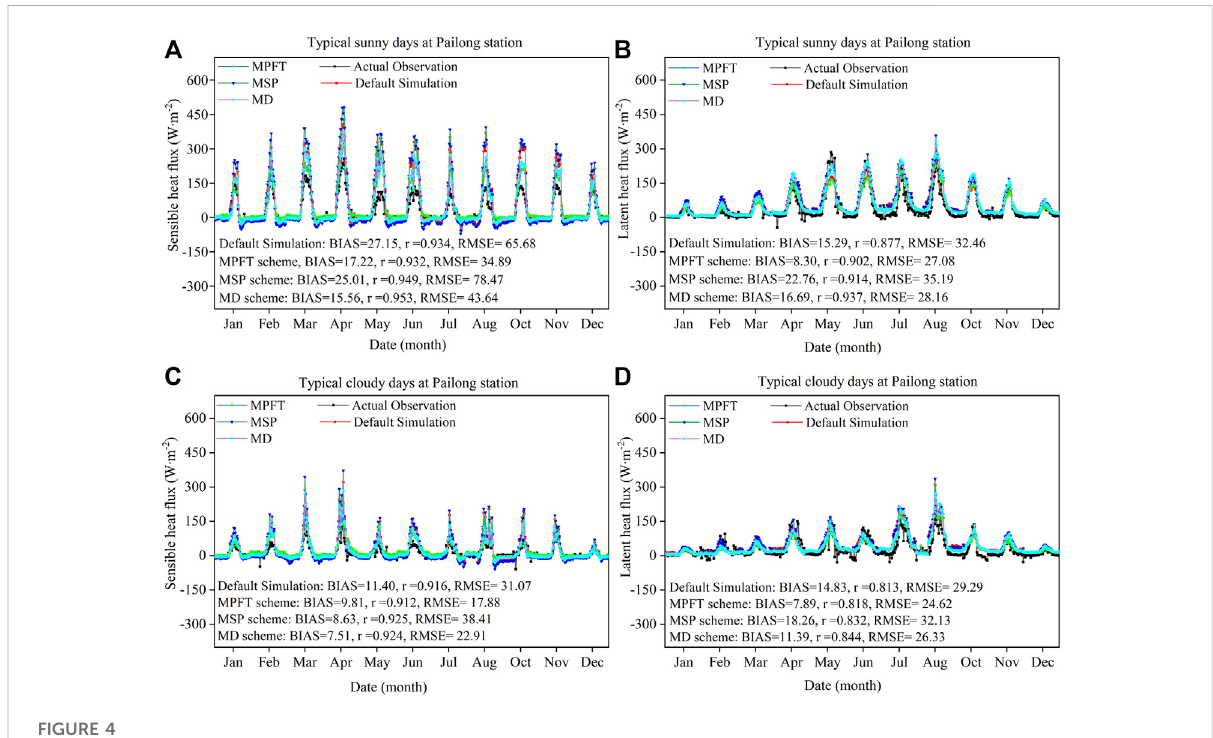
FIGURE 4 As in Figure 3 for Pailong